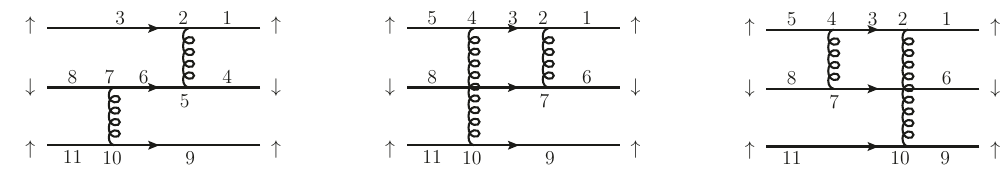
Figure 1. Generic diagrams for gravitational form factor calculations. The numbered places represent the insertion of the energy-momentum tensor operator. The three quark lines denote the leading light-cone wave function configuration for the proton